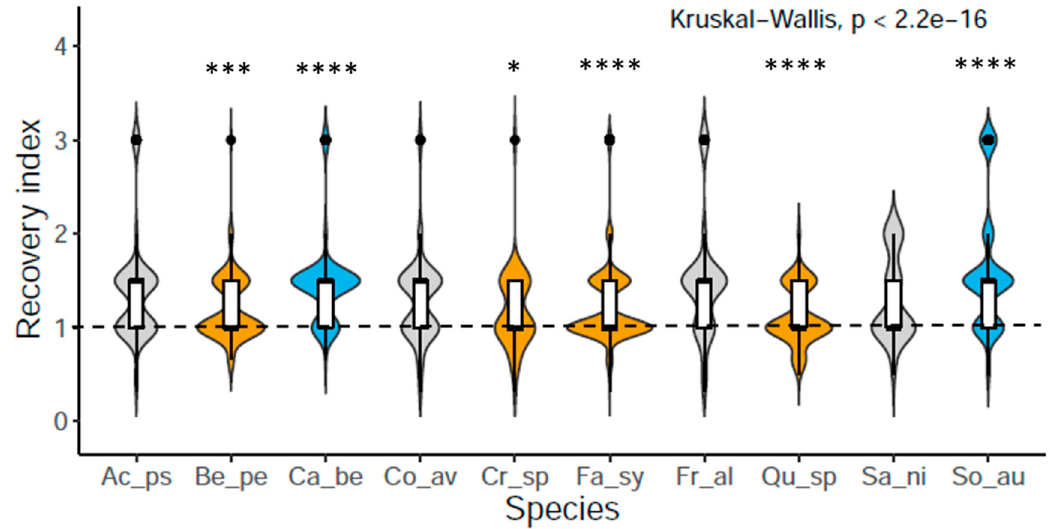
Figure 4. Sapling recovery index and species significance. Values < 1 indicate decline in performance, > 1 indicate increase in performance after the event and 1 indicates same state as during the event (colors: blue > 1, orange = 1, grey = not significant). Ac_ps— Acer pseudoplatanus ; Be_pe— Betula pendula ; Ca_be— Carpinus betulus ; Co_av— Corylus avellana ; Cr_sp— Crataegus spp.; Fa_sy— Fagus sylvatica ; Fr_al— Frangula alnus ; Qu_sp— Quercus spp.; Sa_ni— Sambucus nigra ; and So_au— Sorbus aucuparia . Stars show the statistical significance between species (* p < 0.05, ** p < 0.01, *** p < 0.001, **** p < 0.0001).